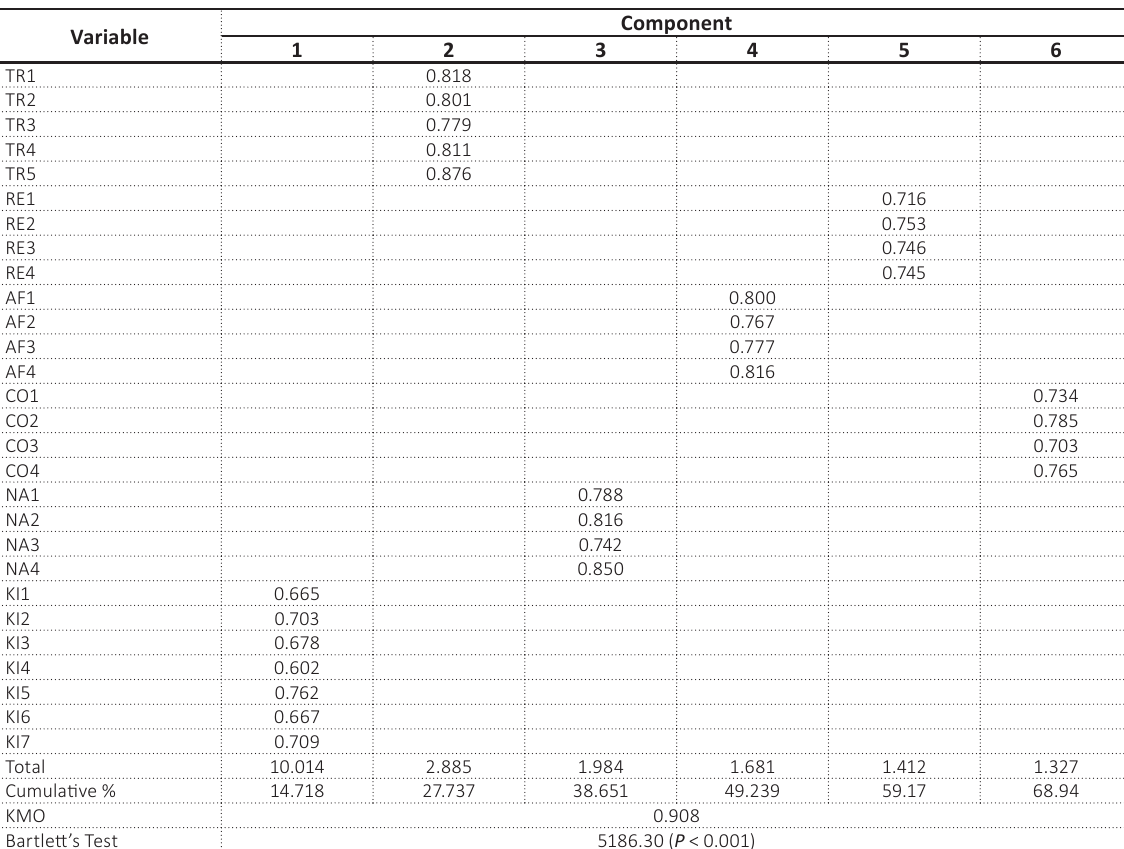
Table 4. Validity